Question: Draft a figure caption describing what is shown.
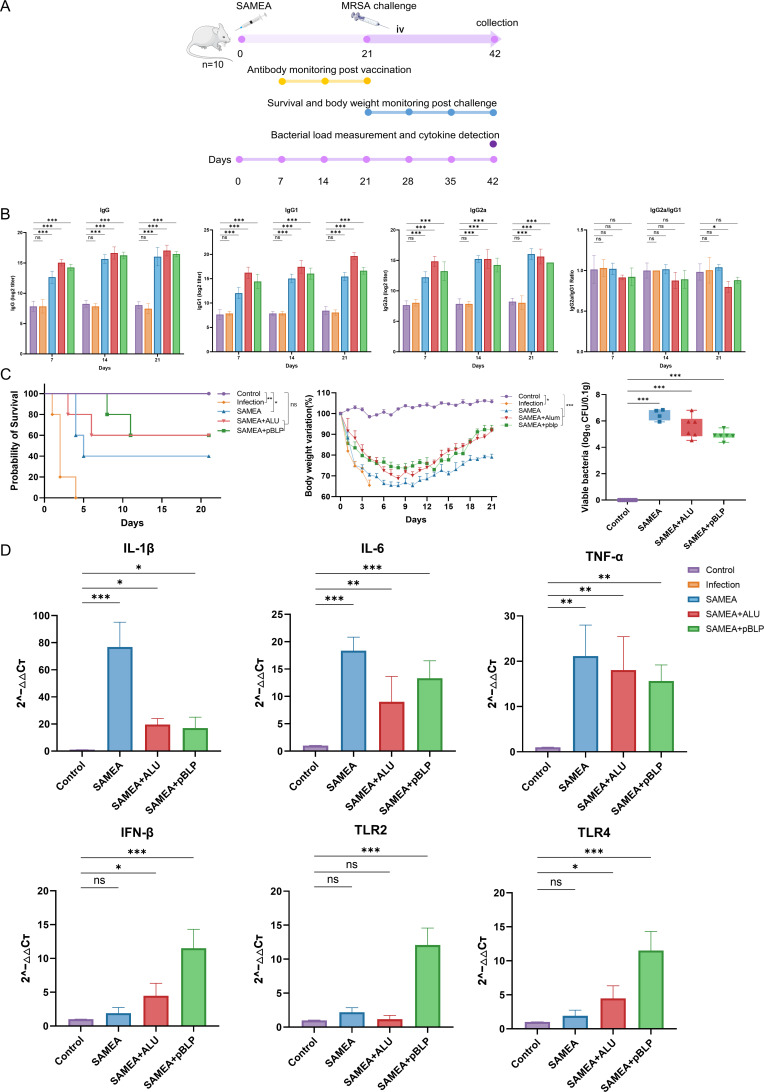
Answer: SAMEA with one dose protects mice against challenge with MRSA. ( A ) Schematic diagram of the vaccination and challenge timeline. ( B ) Levels of specific IgG, IgG1, and IgG2a antibodies and the IgG2a/IgG1 ratio ( n = 10). ( C ) Survival rates, body weight changes, and bacterial loads in kidneys after MRSA challenge ( n = 10). ( D ) Relative mRNA expression levels of IL-1β, IL-6, IFN-β, TNF-α, TLR2, and TLR4 ( n = 10). Data are presented as mean ± SD. Significance was determined by one-way ANOVA with Tukey’s post hoc test or Log-rank test (for survival) (* P < 0.05, ** P < 0.01, and *** P < 0.001).